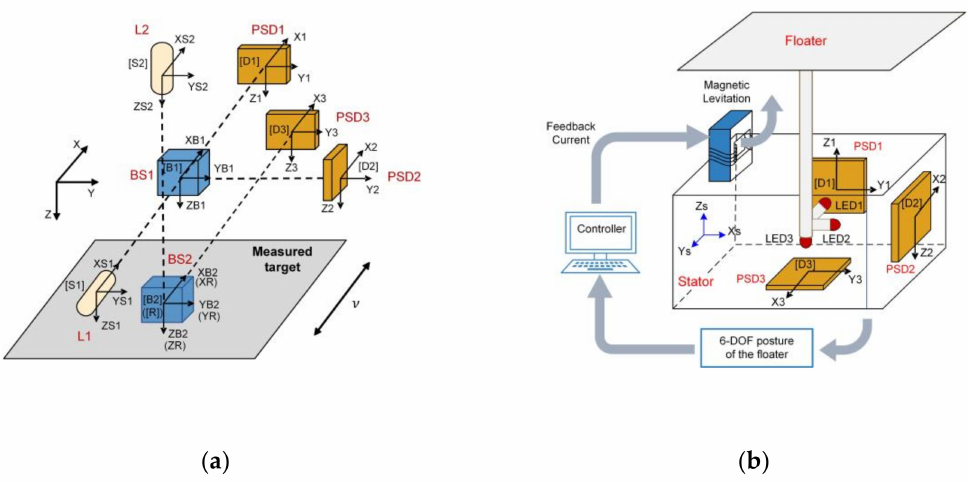
Figure 13. ( a ) 6-DOF geometric motion measurement system for calibrating the mMT; ( b ) 6-DOF posture measurement system used in